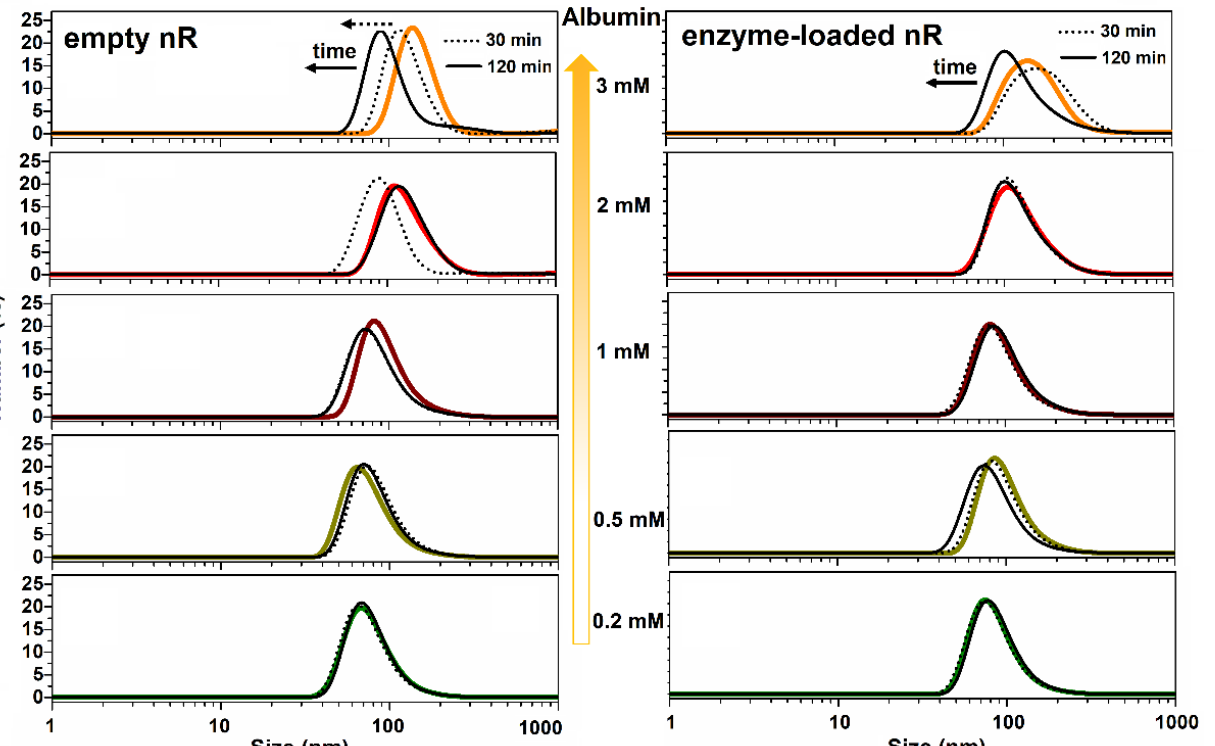
Figure 5. Osmotic pressure effect on the size (diameter, d, in nm) of a nanoreactor as a function of incubation time (0, 30, and 120 min) in concentrated solutions of bovine serum albumin (increasing from 0.2 to 3 mM). Left: empty polymersomes; right: enzyme-loaded polymersomes (the enzyme is a 70 kDa PTE at a concentration inside nR of 0.9 mM). The polymeric envelope of nR was a polyethylene glycol-polypropylene sulfide copolymer. [ E ] nR < [ Albumin ] (authors’ unpublished results).